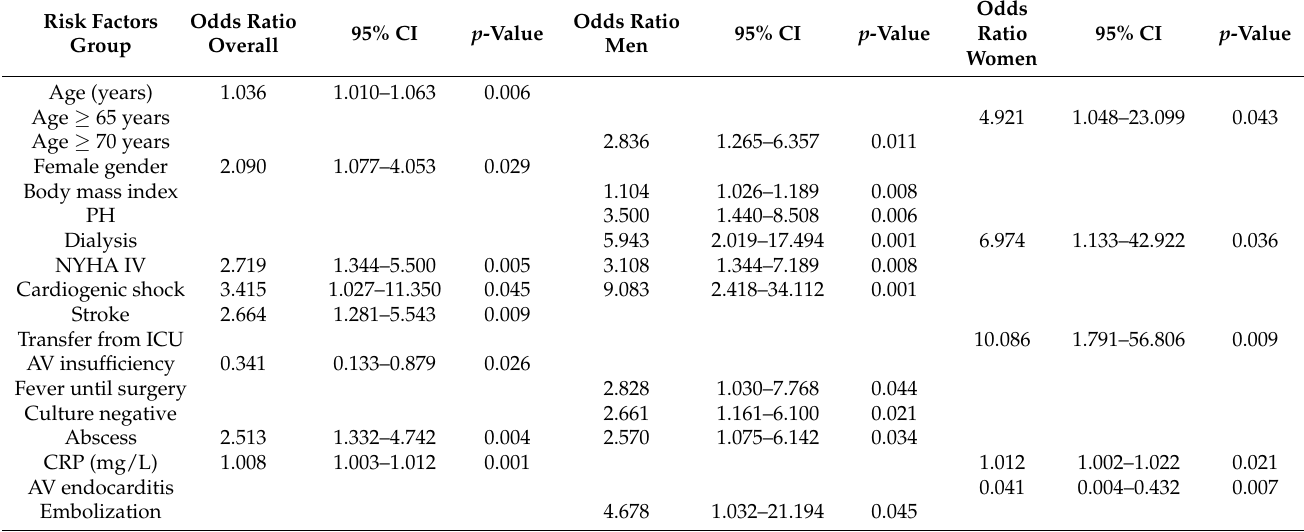
Table 4. Independent preoperative risk factors for 30 day mortality.